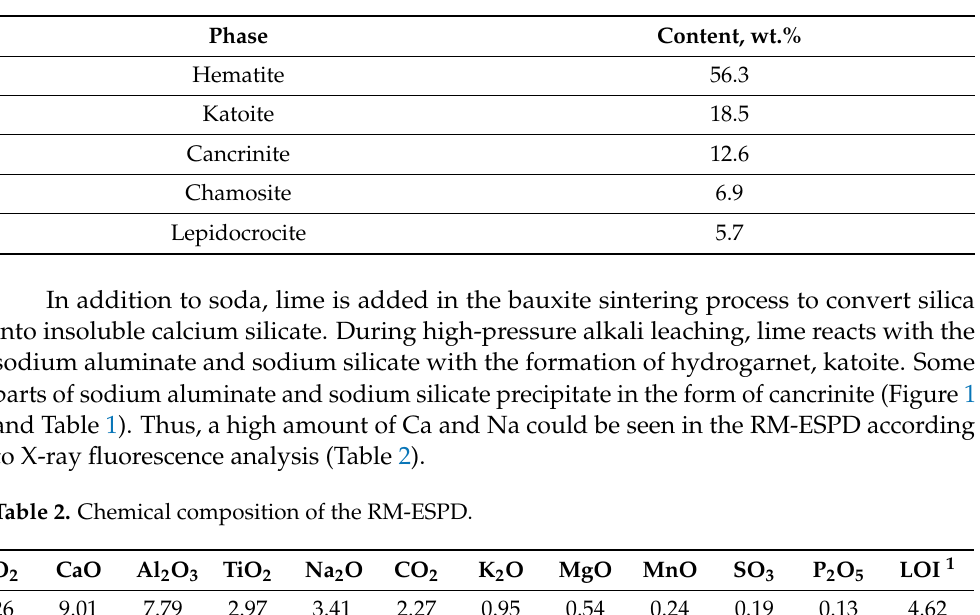
Figure 1. XRD patterns of: ( a ) The red mud obtained by water-alkali leaching of electrostatic precipitator dust arising from the bauxite sintering process (RM-ESPD); ( b ) solid residue after MgSO 4 leaching. Table 1. Mineralogical composition of the red mud obtained by water-alkali leaching of electrostatic precipitator dust arising from the bauxite sintering process (RM-ESPD).